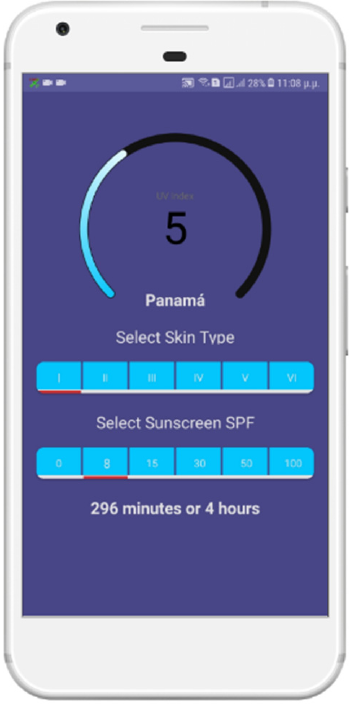
Figure 7. Application screenshots: sun UV and exposure time without burning.